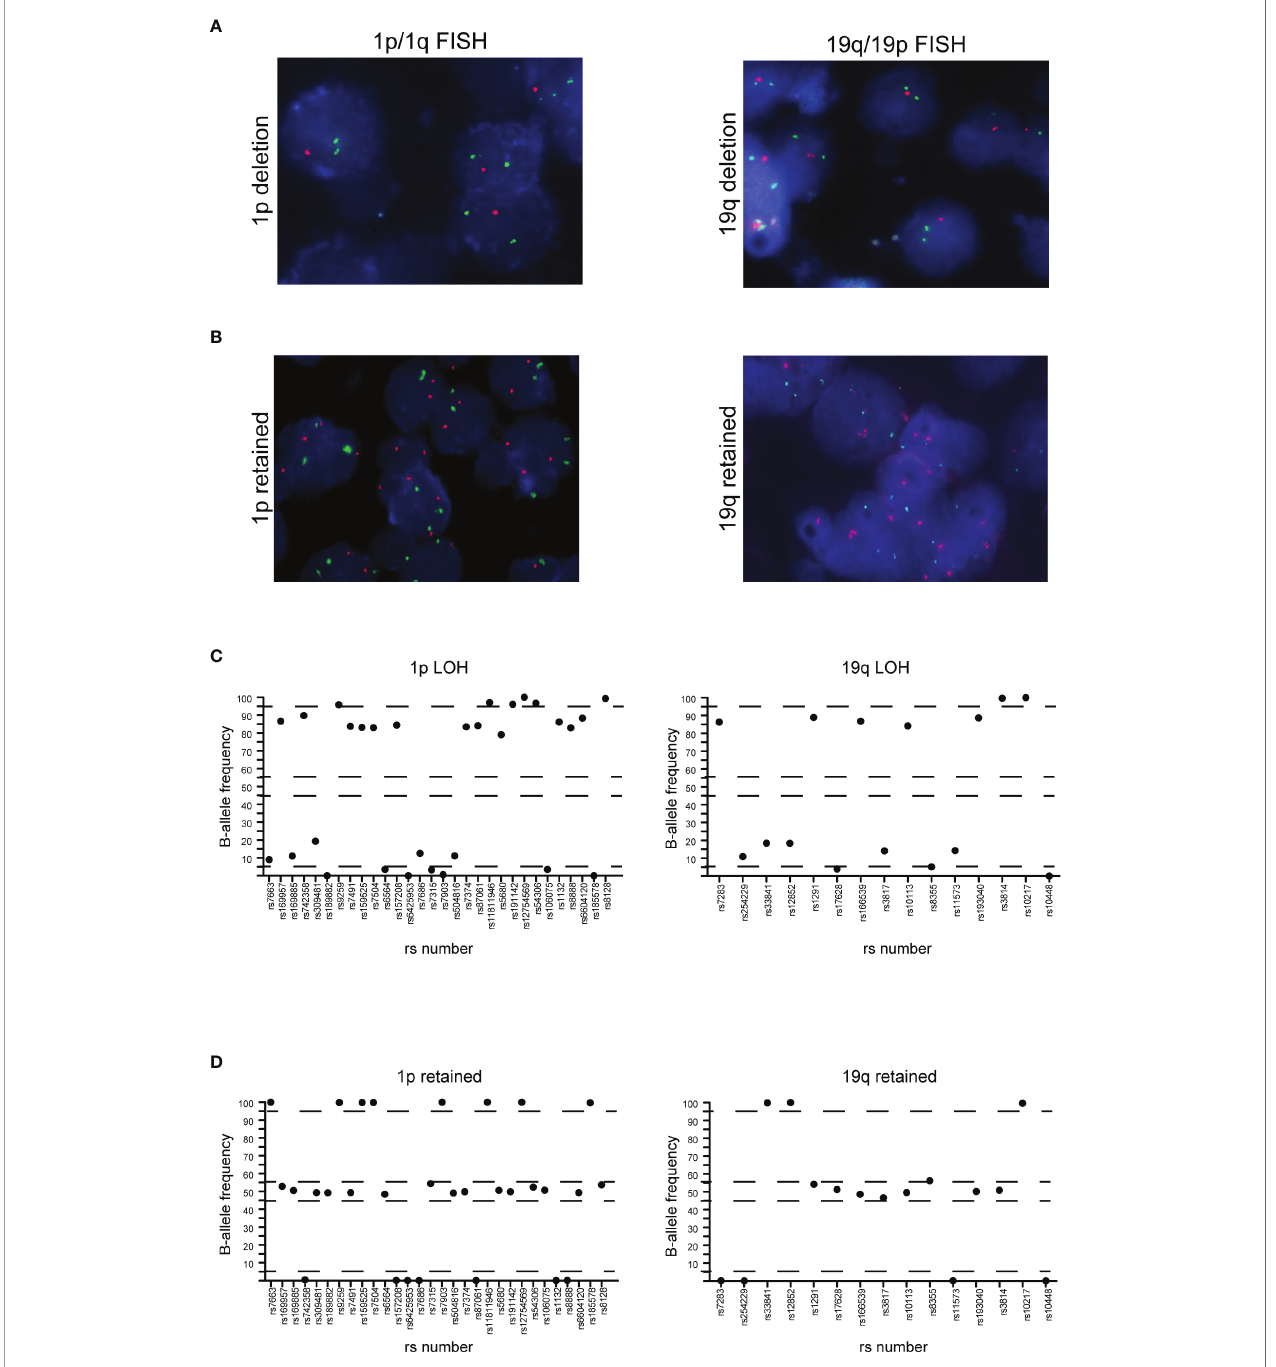
FIGURE 4 | Correlation between FISH and NGS detection of 1p/19q co-deletion. (A) 1p (left panel) and 19q (right panel) co-deletion in a case of oligodendroglioma detected by FISH. (B) 1p (left panel) and 19q (right panel) negative control. In both cases, red dots represent 1p36.3 and 19q13.3 signals while green dots represent 1q25.2 and 19p13.2 signals. (C) Distribution of B-allele frequencies based on loss of heterozygosis (LOH) of single nucleotide polymorphisms (SNPs) in NGS of an oligodendroglioma sample with typical 1p (left panel) and 19q (right panel) co-deletion. (D) GBM without LOH and genomic alterations of chromosome 1p (left panel) and 19q (right panel). The x axis shows the investigated SNPs (rs number was reported) while the y axis shows the percentage variant (B-allele frequency). Dashed lines indicate the arbitrarily set homozygosis range of 0-5% and 95-100%. The range of heterozygosis is de fi ned as being between 45% and 60% of the B-allele frequency. LOH was called when the B-allele frequency of a SNP was outside the established range for homo- and